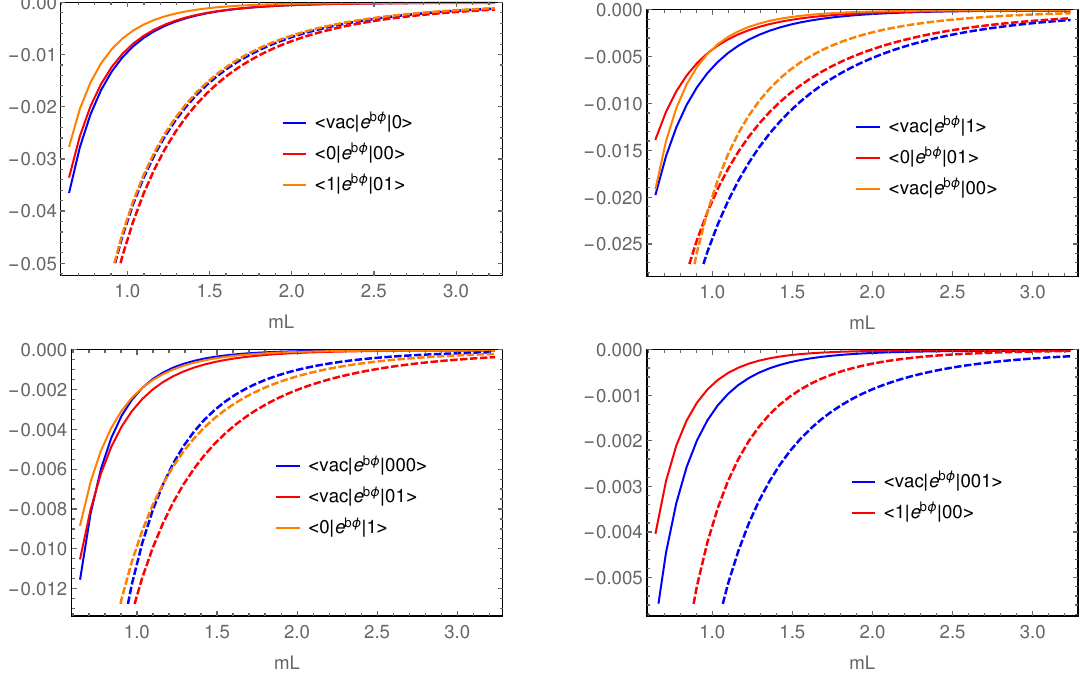
Figure 7 . Theoretical predictions in sinh-Gordon model for various (cid:12)nite volume form factors of the primary operator e b’ , as compared to numerical TCSA data (the latter is subtracted from each data set) at b = 1. Polynomial (Pozsgay-Tak(cid:19)acs) results are depicted by dashed curves, while the results containing the (cid:12)rst exponential corrections, conjectured by the present article, are shown by continuous curves.